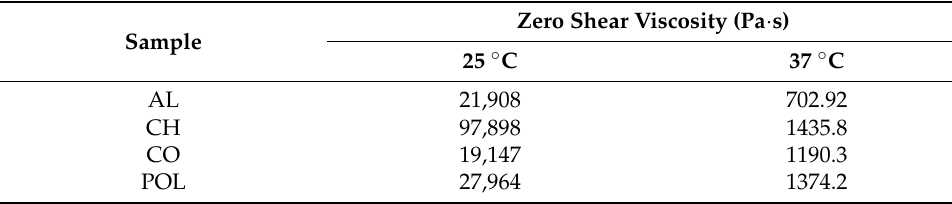
Table 2. Evaluation of wound area, re-epithelialization area and wound. Contraction rate (WCR) for the excision model